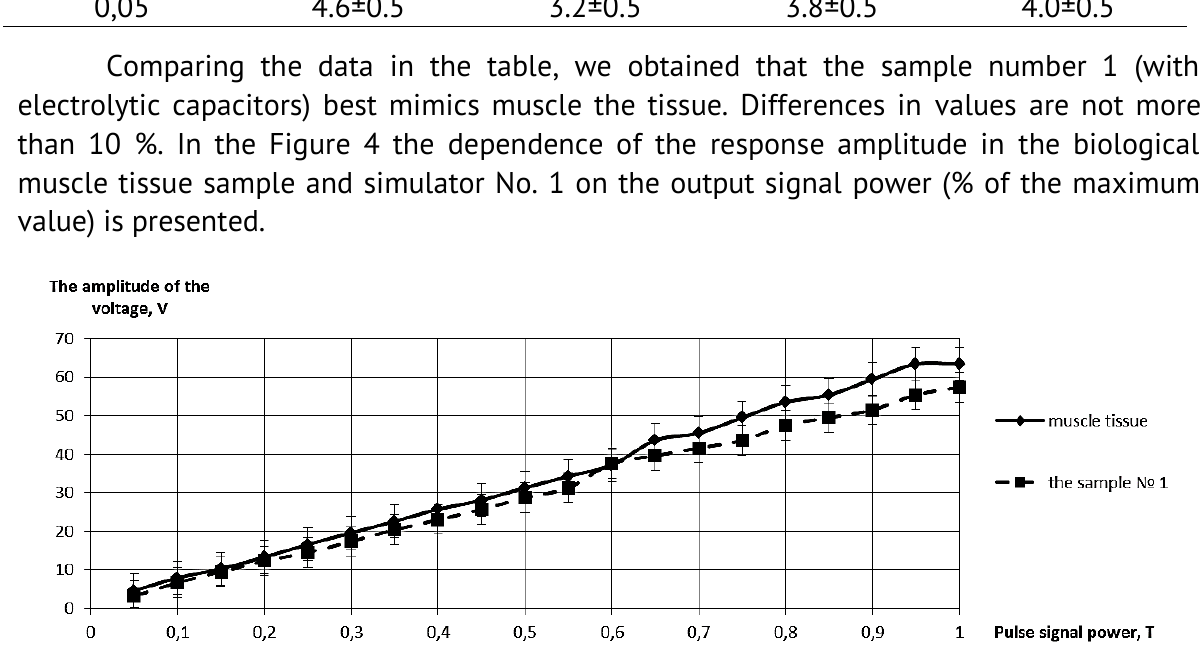
Figure 4. The dependence of the response amplitude in a biological sample of muscle tissue and simulator No. 1 on the output signal